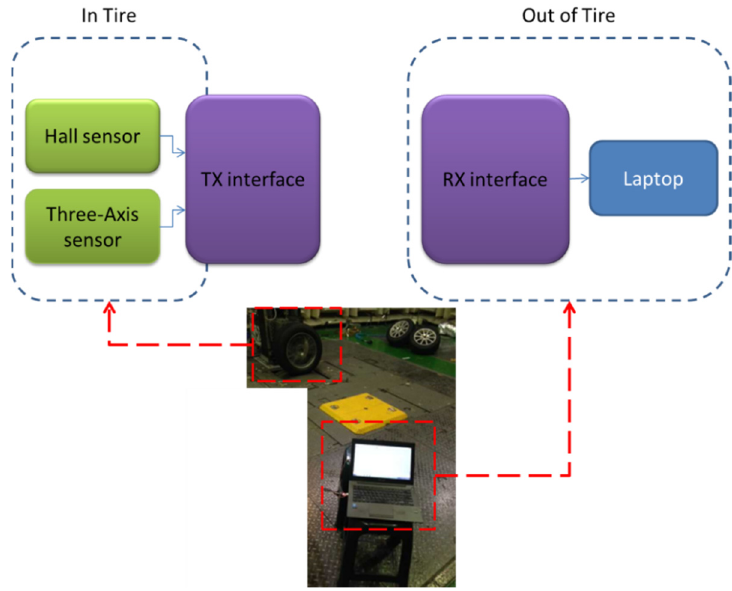
Figure 1. System prototype.